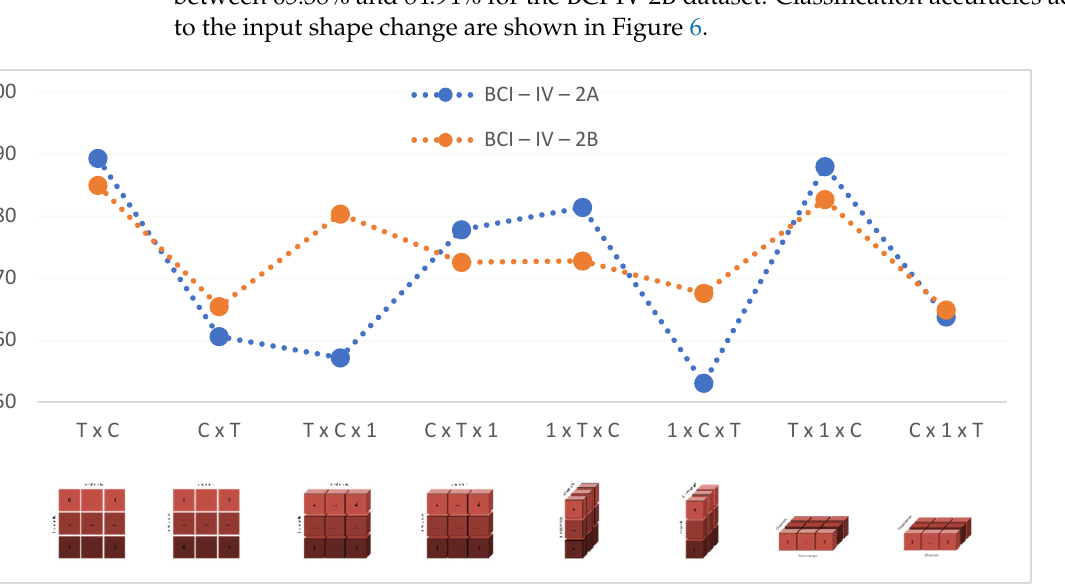
Figure 6. Average Accuracy Values for each Input Shape.